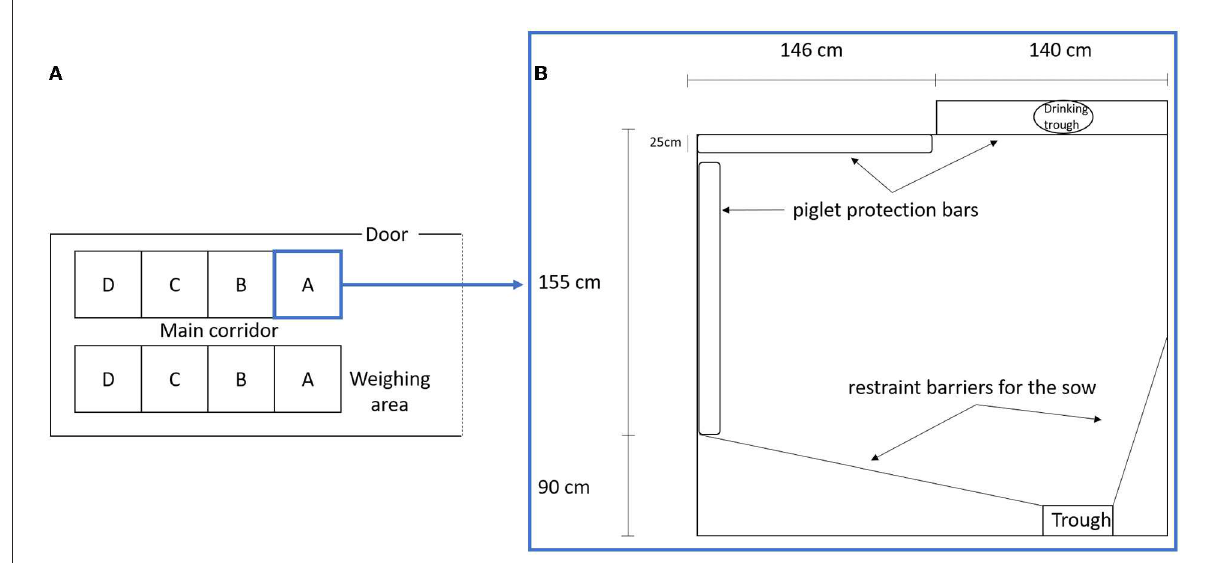
FIGURE1 (A) Scheme of farrowing unit room, A, B, C, and D, represents the pen position in relation to the principal door and weighing area. (B) Scheme of a farrowing